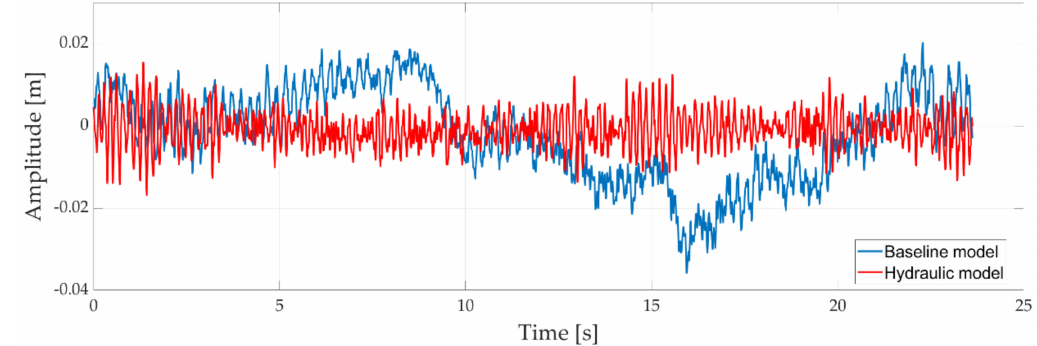
Figure 14. Front left wheel vertical motion relative to the road over a realistic road profile.